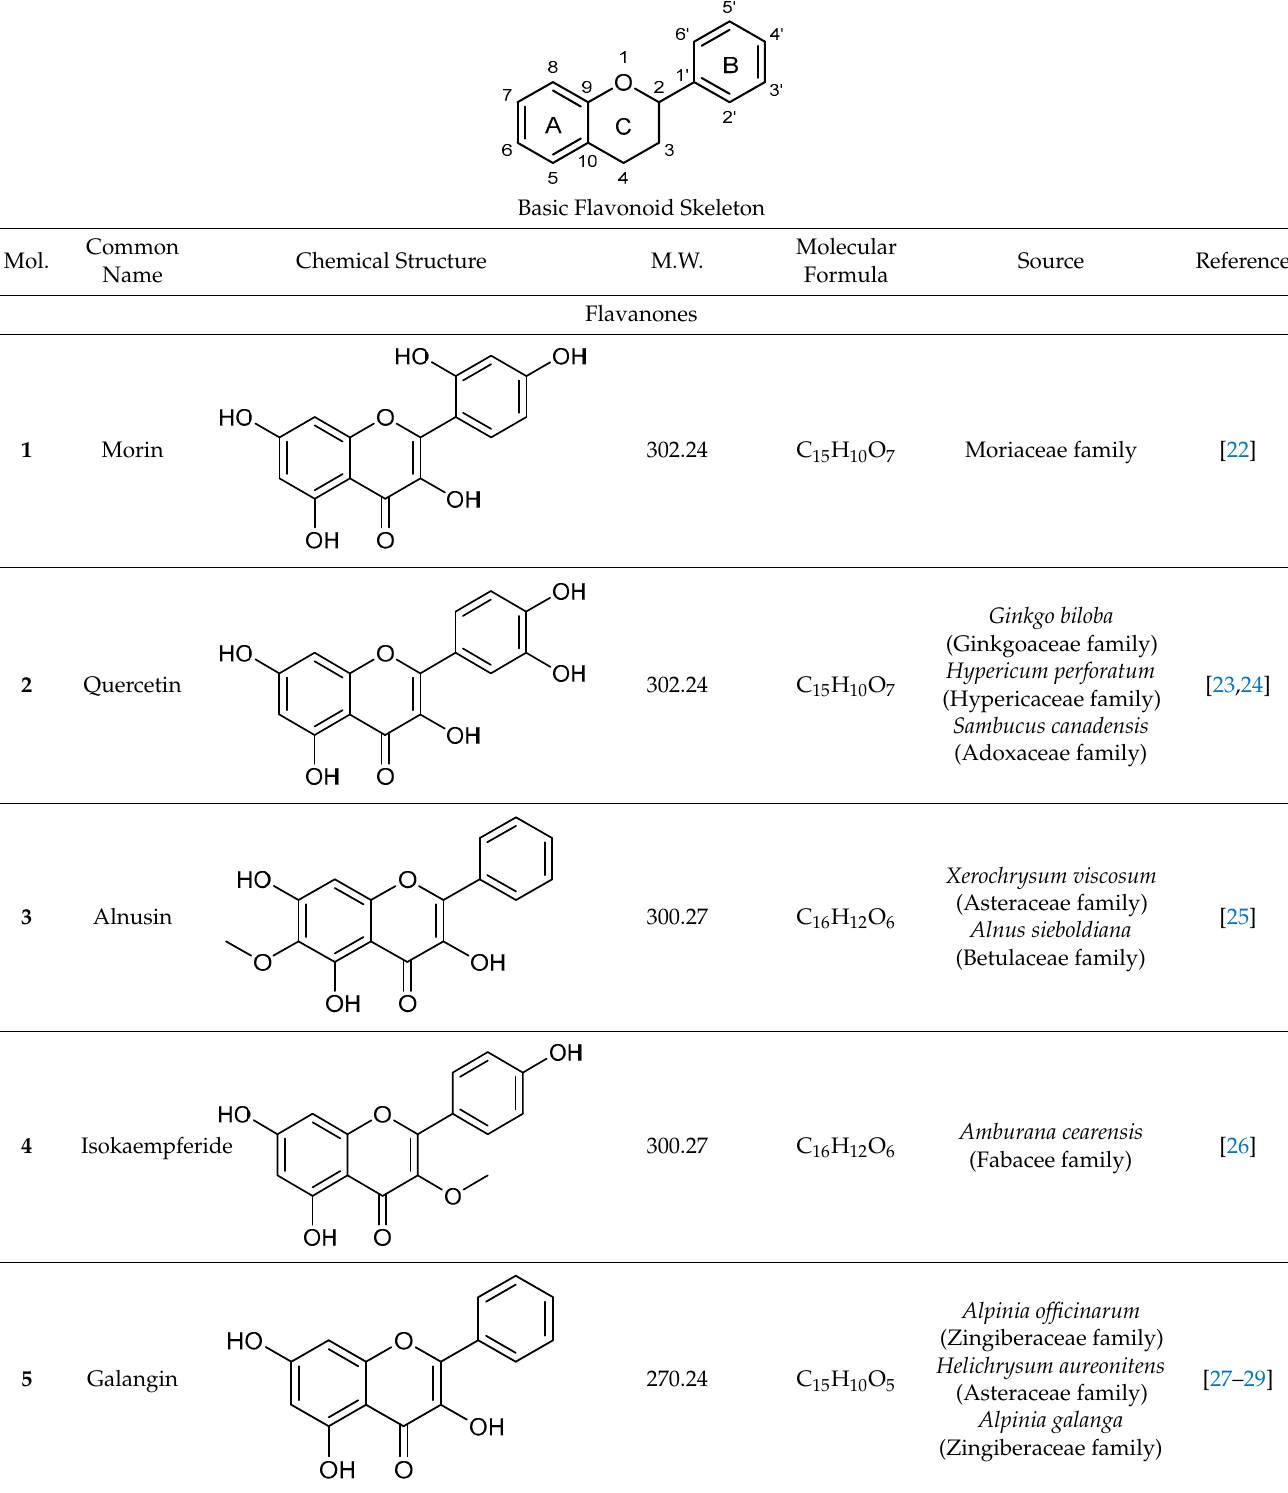
Basic Flavonoid Skeleton